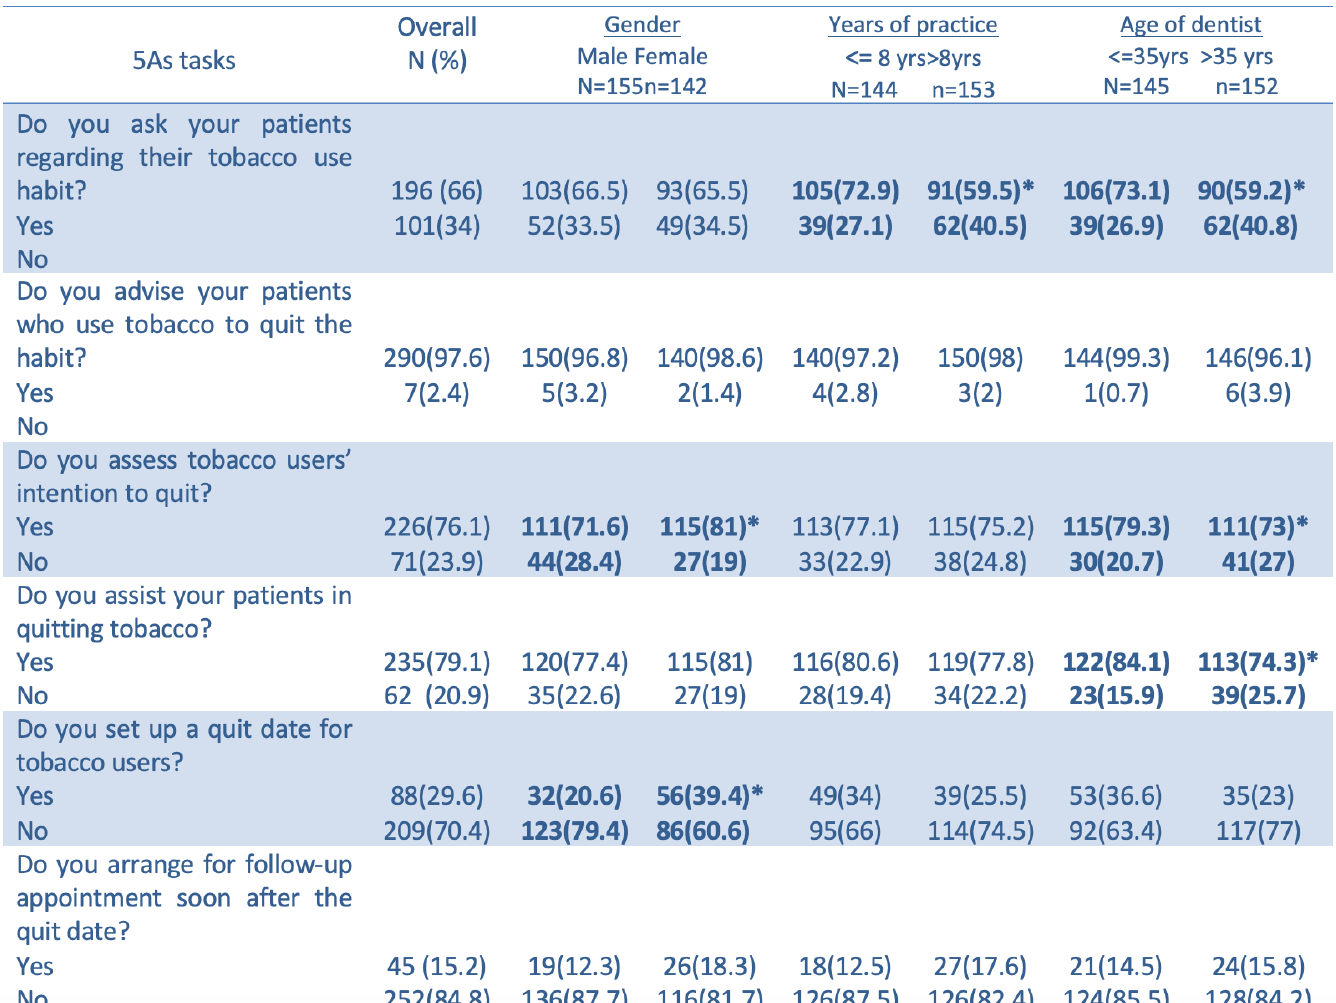
Table 3. Responses of the parDcipaDng denDsts to quesDons related to 5As approach of tobacco cessaDon.